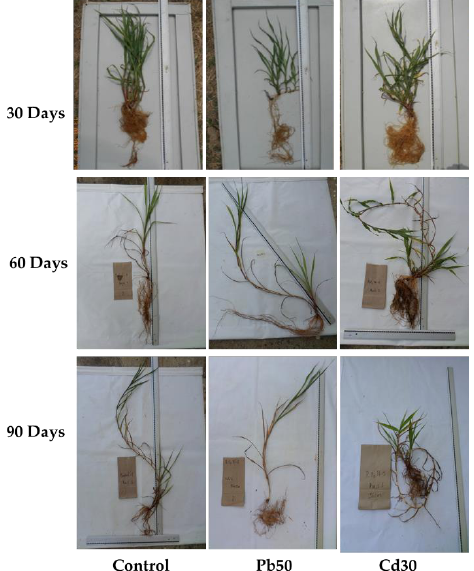
Figure 6. Seedlings of P. fasciculatum in a greenhouse under to Cd and Pb-stress for 90 days. Treatments: Cd30 = 30 mg kg -1 ; Pb50 = 50 mg kg -1